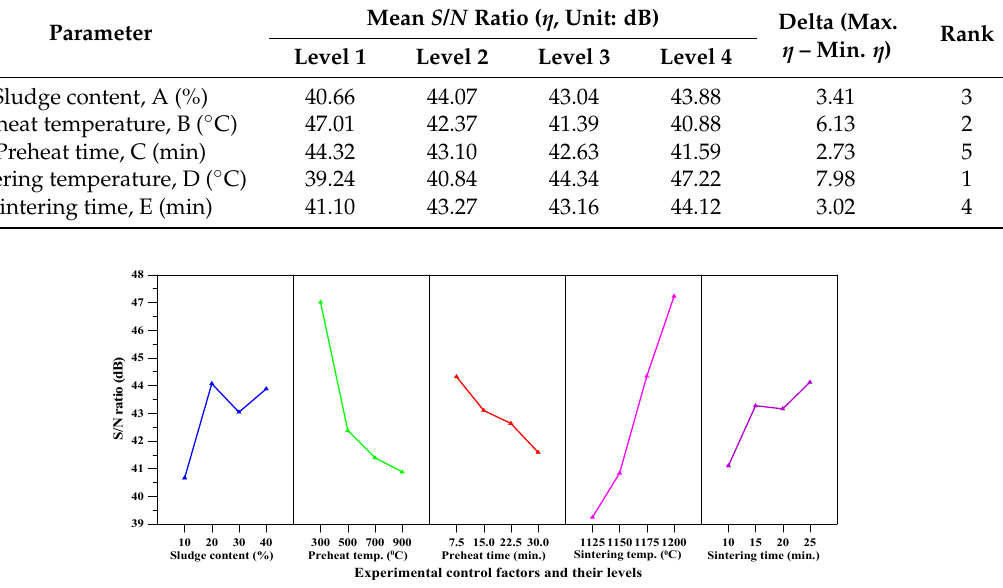
Figure 5. S / N response graph for bloating ratio. Table 10. S / N response table for bloating ratio.